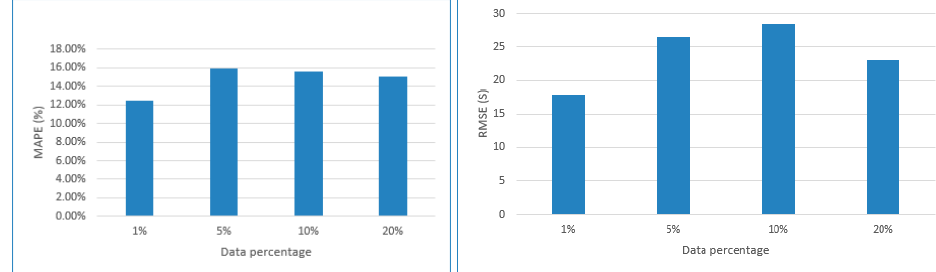
Figure 10. The Mean Absolute Percentage Error (MAPE) and Root Mean Square Error (RMSE) of predicted link travel time corresponding to different data percentage.